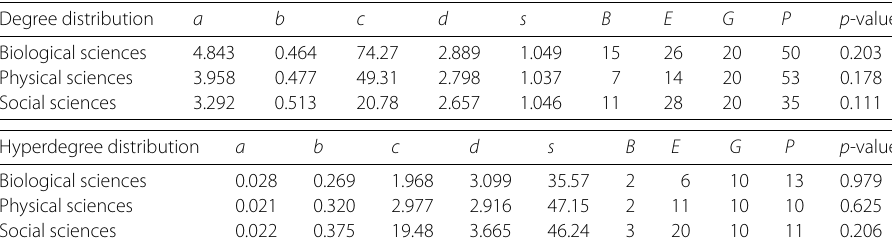
Table 4 The parameters of fitting